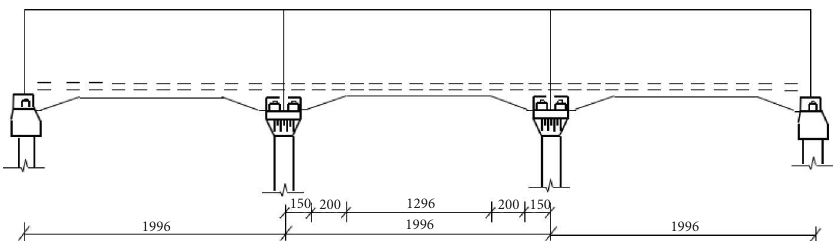
Figure 4: Aqueduct elevation diagram (unit: mm).